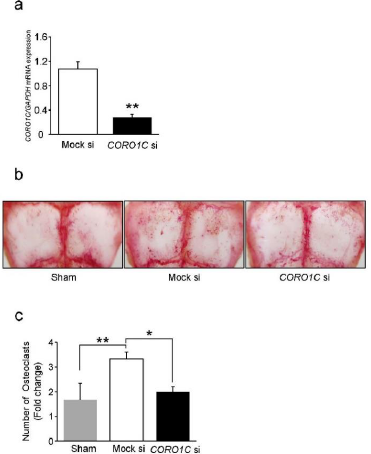
Figure 8. Effects of Coronin1C knockdown on osteoclastogenesis in vivo. Mouse calvaria were implanted with collagen sponges that were pretreated with mock or CORO1C siRNA. Sham mice underwent only periosteal avulsion of the calvaria bone. The next day, RANKL was added to the collagen sponges. The calvaria were sacrificed on day 6 for mRNA collection ( a ) and TRAP staining ( b , c ). ( a ) The CORO1C mRNA levels were analyzed by qPCR. ** p < 0.01; compared with the mock si. ( b ) TRAP-stained images of multinucleated cells induced to Sham and Mock si, CORO1C si calvaria treated with RANKL for 6 days. ( c ) The number of TRAP-positive cells was counted and normalized to Sham. * p < 0.05, ** p < 0.01 ( n = 3).